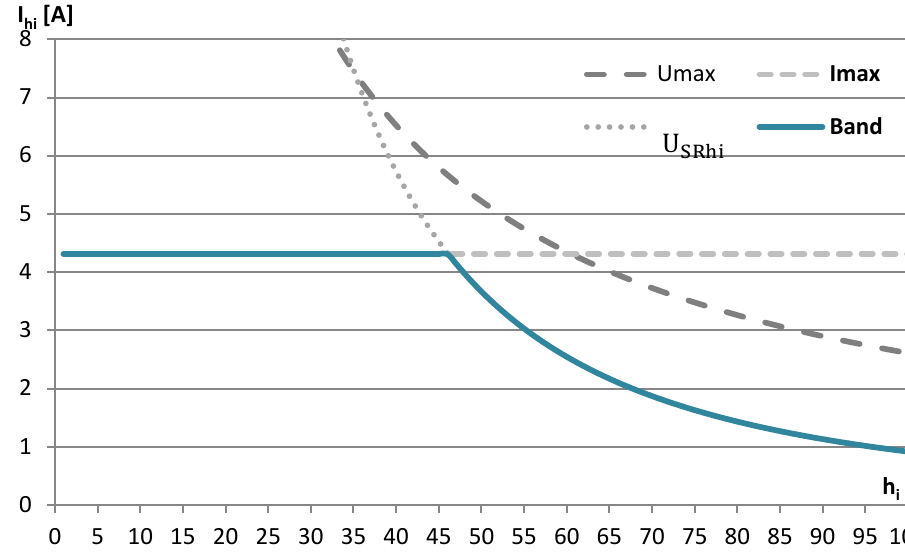
Figure 2. The maximum rms values of the higher harmonics of the output current able to be generated by the power source for a given rms value of the main harmonic of this distorted current equal to 6.5 A with load inductance equal to 5 mH.